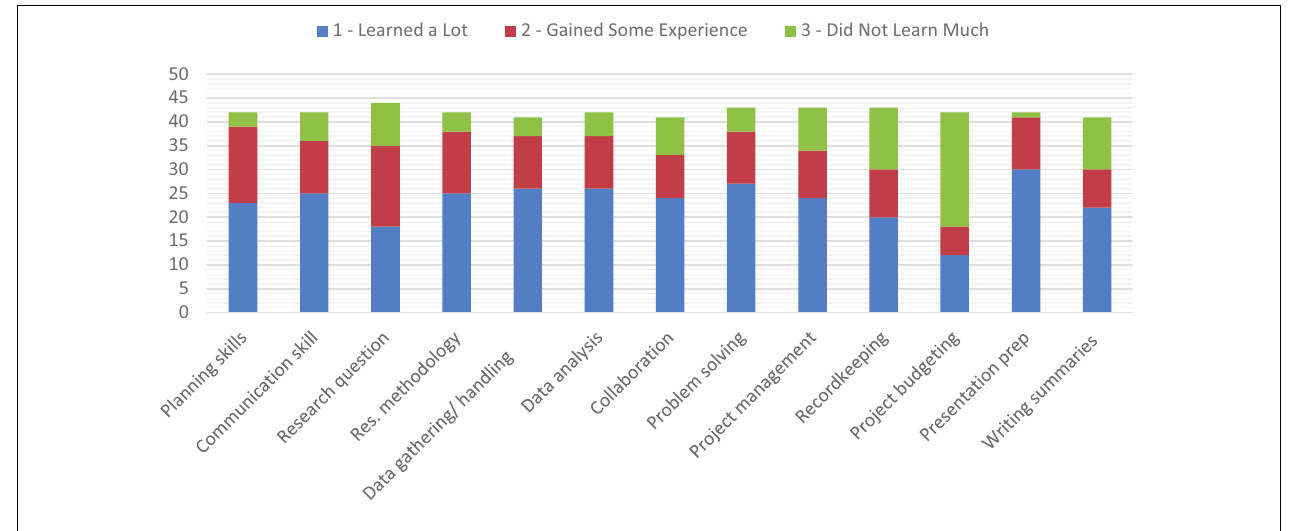
FIGURE 3 | Learning reported regarding research